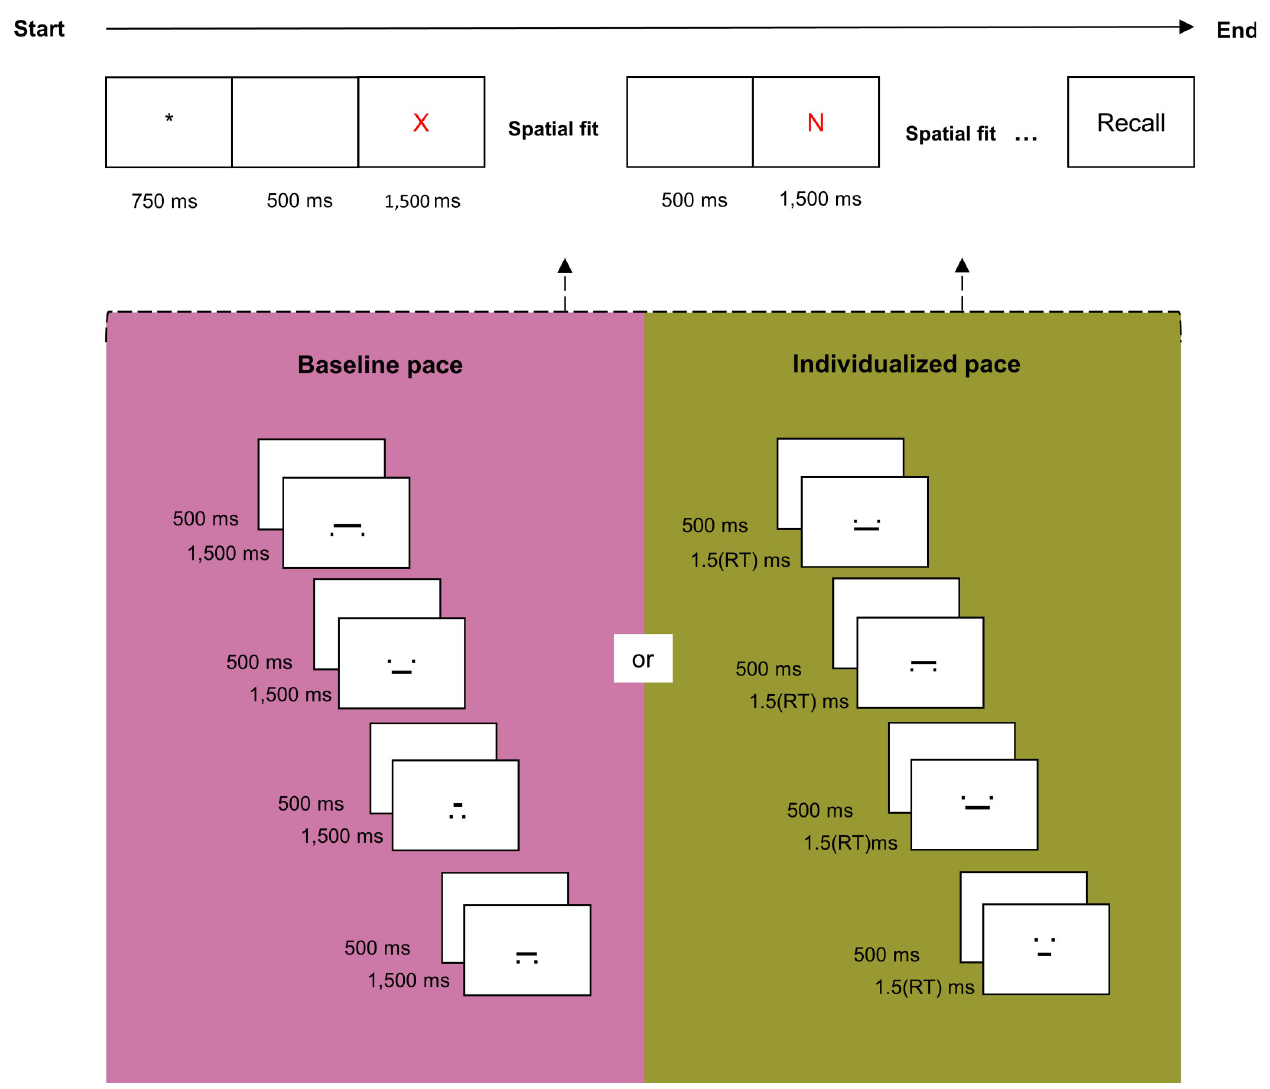
Fig 5. Procedure of Experiment 2. Participants were presented with increasingly longer lists of letters and the letters were interspaced with a spatial fit task. Participants were required to respond if the horizontal bar fit the gap between the two squared. The duration of the fit space task was the same for all participants in the baseline condition and it was adapted according to each participant’s mean RT in the individualized